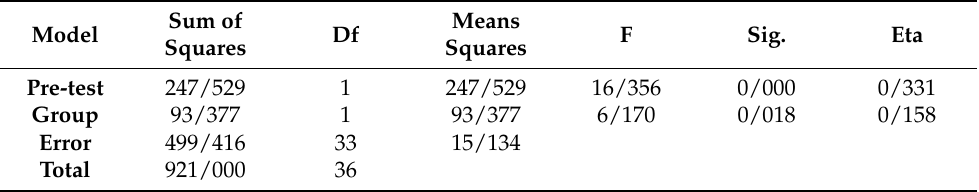
Table 9. Results of univariate analysis of covariance regarding the effect of teaching study strategies on academic vitality. Sum of Means Model Df F Sig. Eta Squares Squares Pre-test